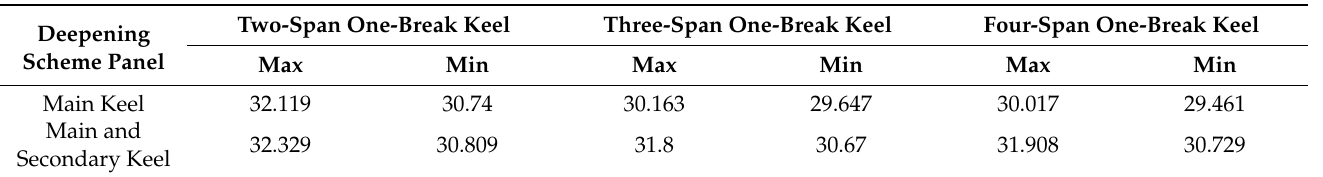
Table 17. Distance between the deepening scheme panel and the comprehensive scheme